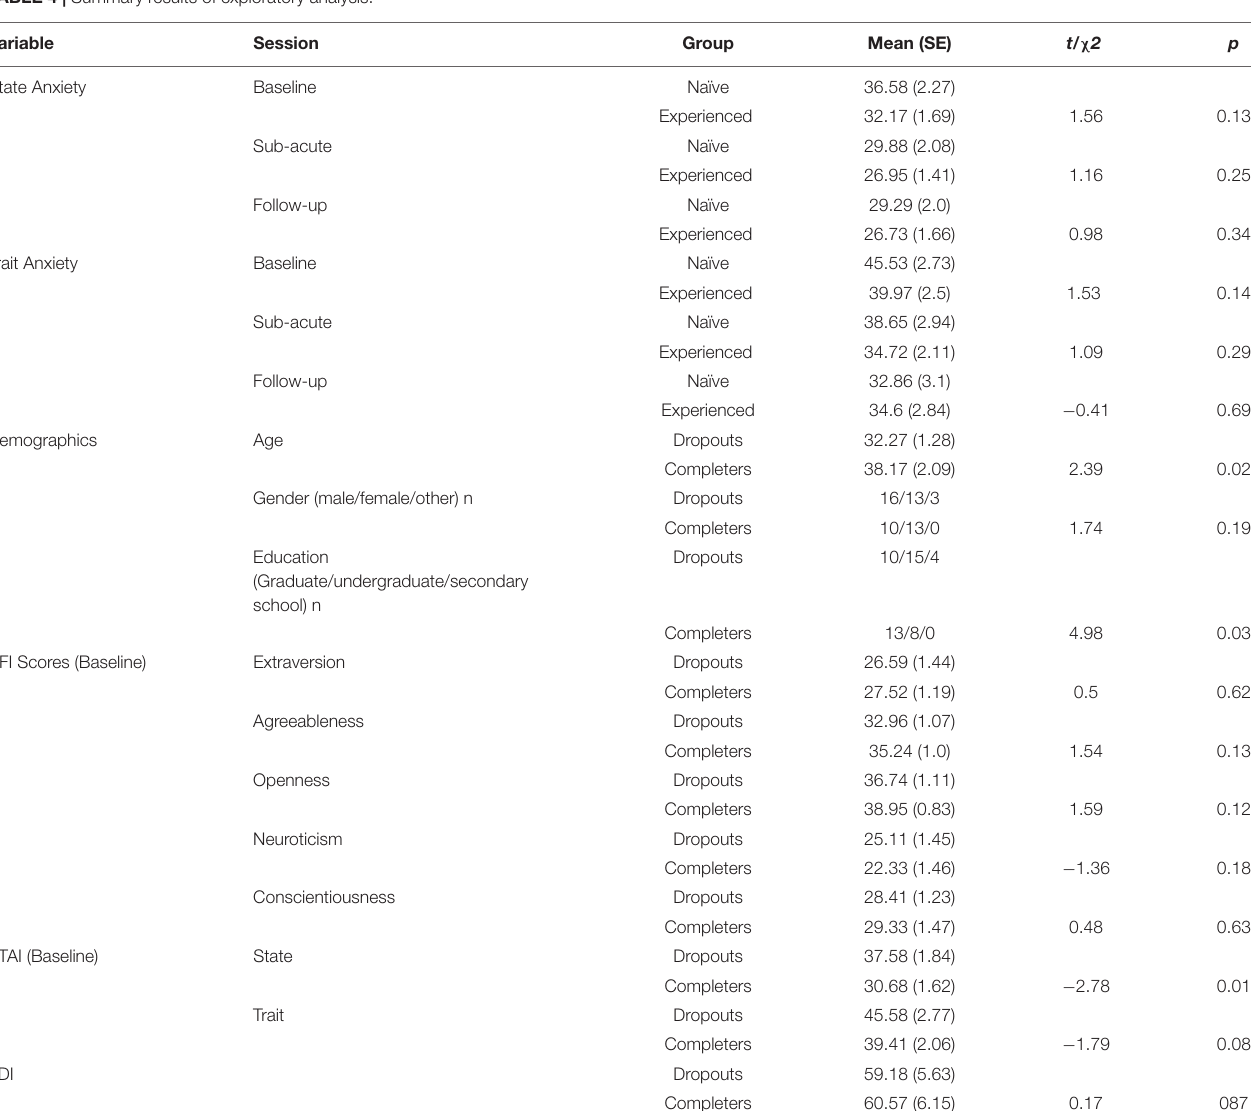
TABLE 4 | Summary results of exploratory